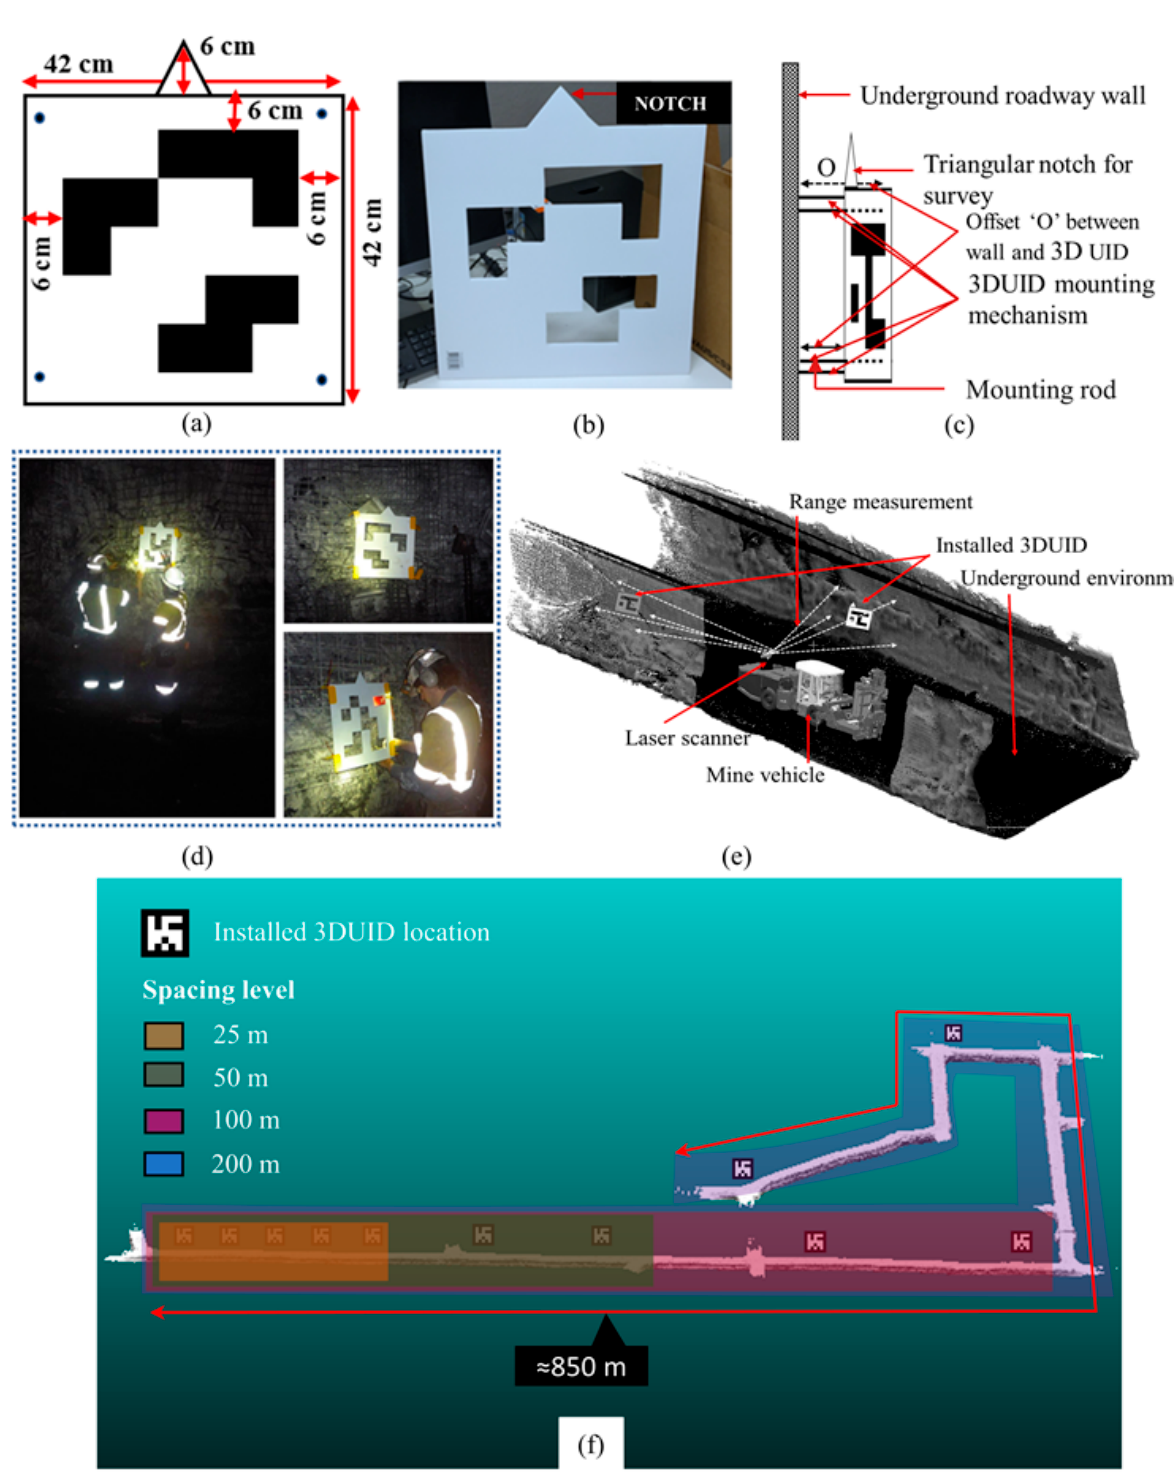
Figure 3. ( a ) Selected dimensions for 3DUID construction shown with an example, ( b ) developed prototype with a triangular notch on top, ( c ) schematic view of 3DUID installation at an offset distance from the wall for depth perception, ( d ) actual installation of 3DUID at the mine site, ( e ) conceptual scanning of installed 3DUID, and ( f ) division of study area into several subsections to investigate the impact of inter 3DUID spacing on georeferencing and data coregistration. The mobile laser scanner was mounted on a mining vehicle which was driven at an average speed of 10 km/h for acquiring point cloud data. The vehicle speed was kept at